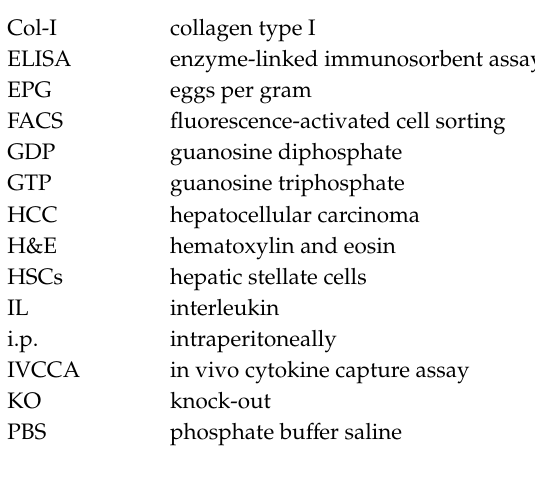
Figure S1: Fasudil does not a ff ect worm burden by S. japonicum